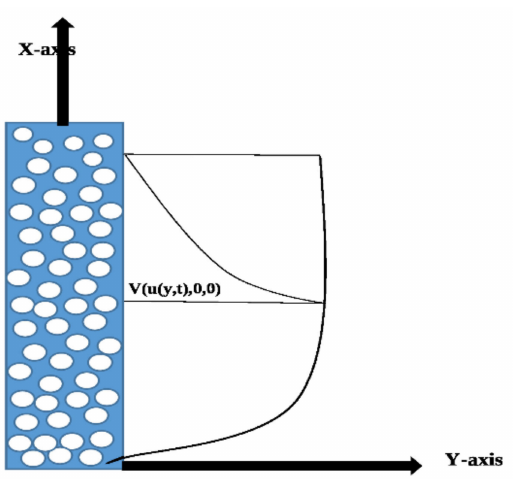
Figure 1. Schematic